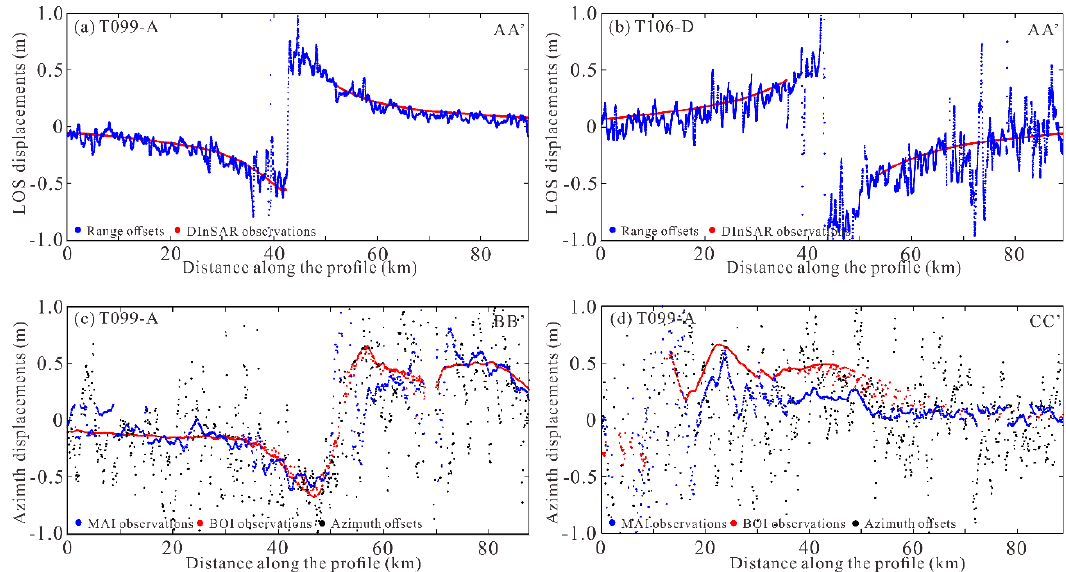
Figure 4. LOS displacements of ascending ( a ) and descending ( b ) tracks derived from the DInSAR and POT methods are compared along the AA ′ profile. The azimuth displacements of the ascending orbit derived from the MAI, BOI and POT methods are compared along the BB ′ ( c ) and CC ′ ( d ) profiles.